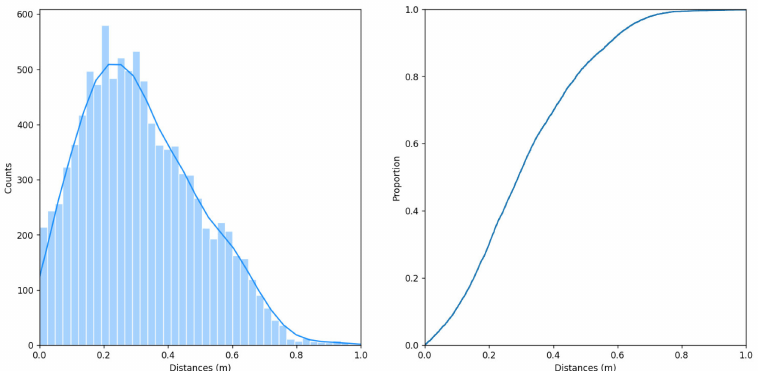
Figure 4. Distribution of linear differences (distances) between two consecutive runs along the same navigation path. Left: counts vs. distances; right: cumulative errors during the